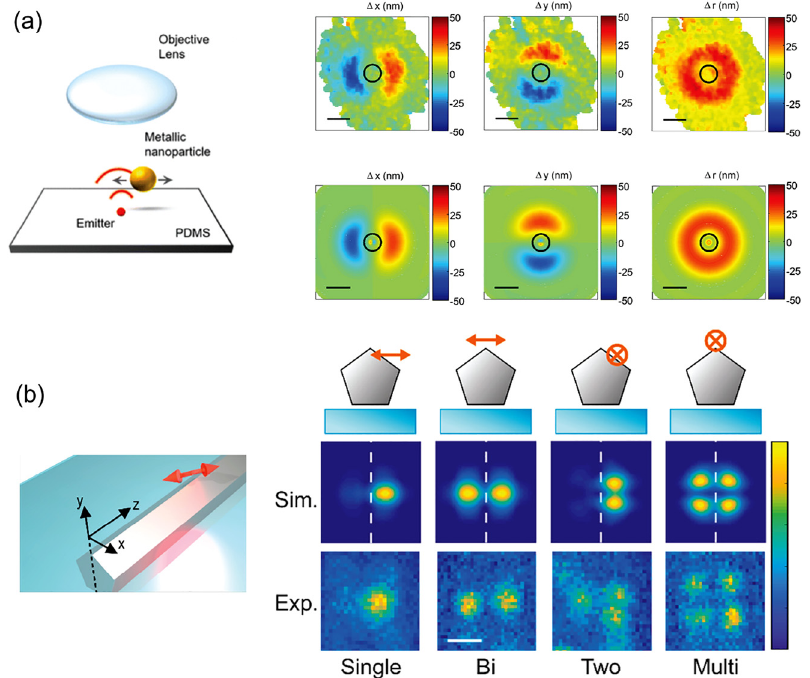
Figure 7: Evidence and analysis of systematic errors in superresolution localization microscopy due to strongly scattering nanophotonic